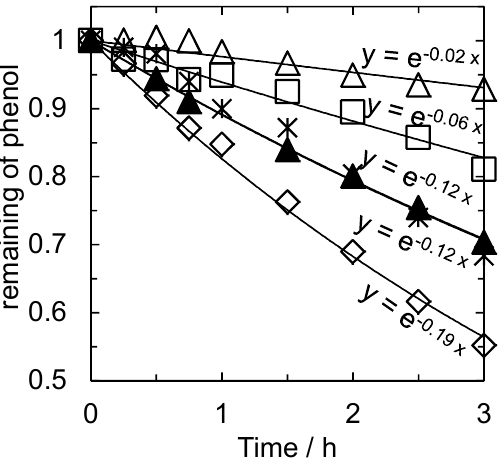
Figure 4. Phenol decomposition with exponential curve fitting for the water-purification reactors. Open triangles: BLB/TMiP reactor; open squares: O bubbling alone (0.5–1.0 mg/L); 3 solid triangles: BLB/TMiP/O reactor (0.5–1.0 mg/L); asterisks: excimer alone; open 3 diamonds: excimer/TMiP reactor. Reproduced with permission from Ochiai et al . [16], Chemical Engineering Journal; published by Elsevier,